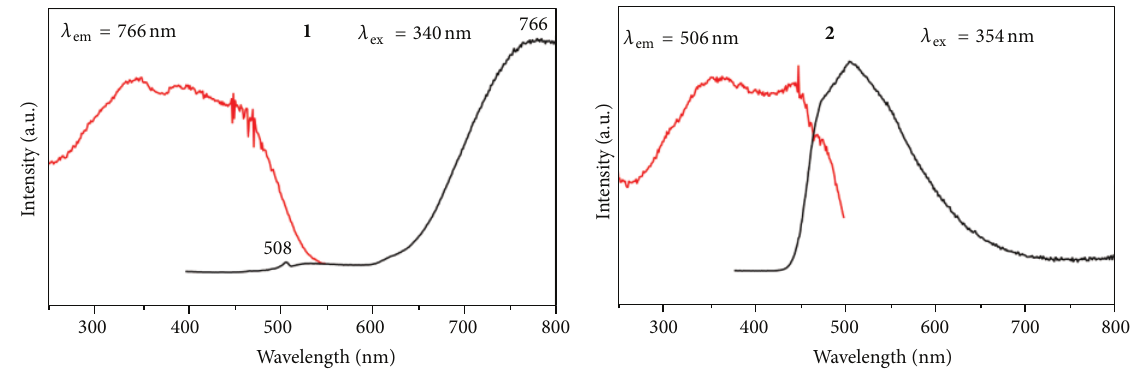
Figure 6: Solid-state excitation and emission spectra of 1 and 2 at room